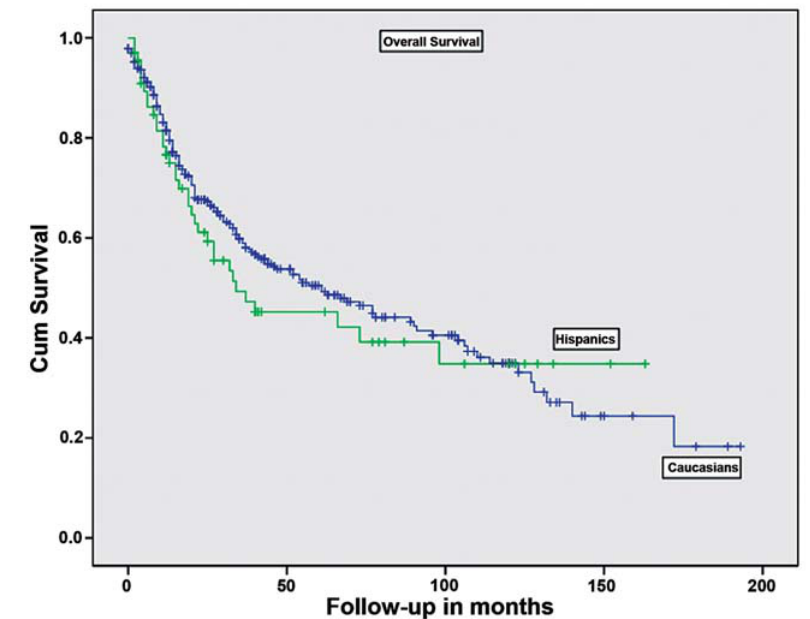
Figure 1 – Overall